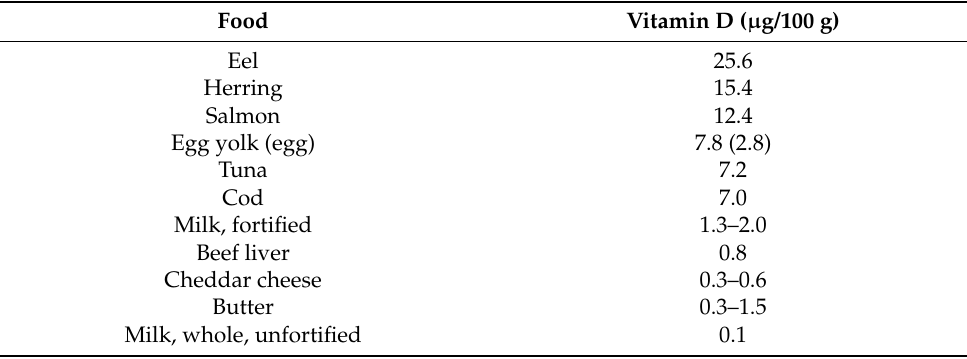
Table 1. Selected foods and their vitamin D content per 100 g